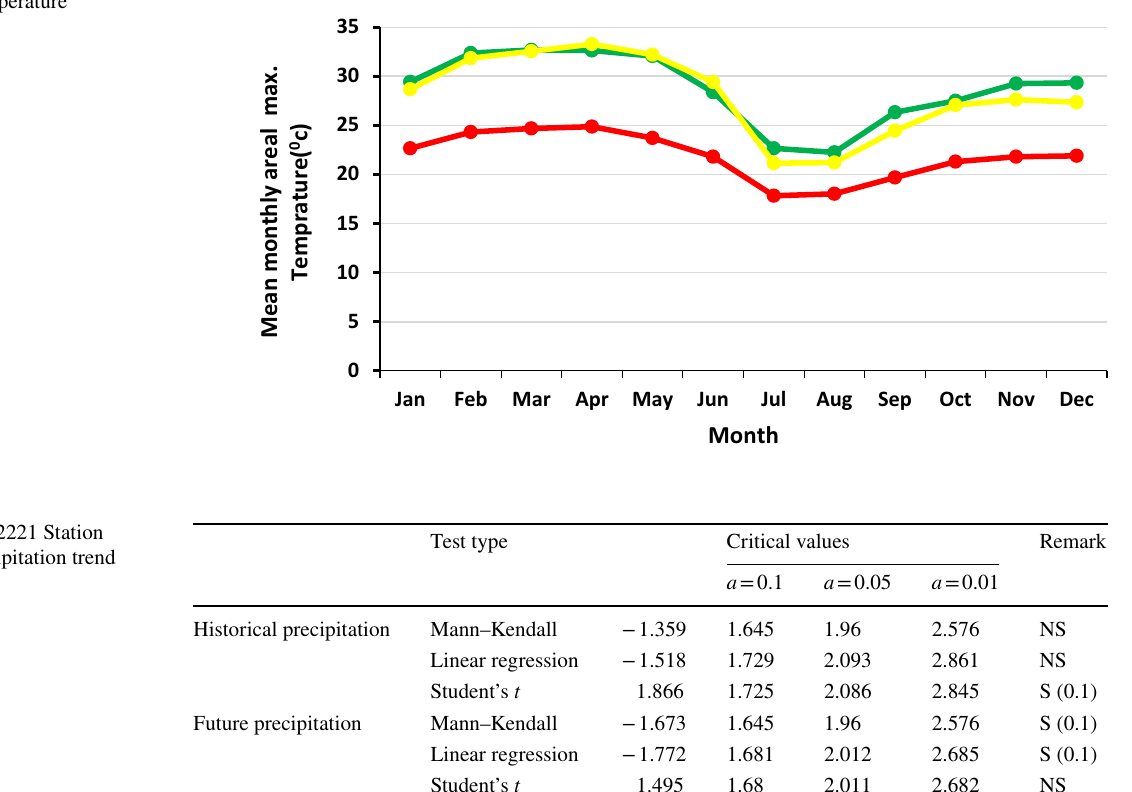
Fig. 3 Mean monthly areal maximum